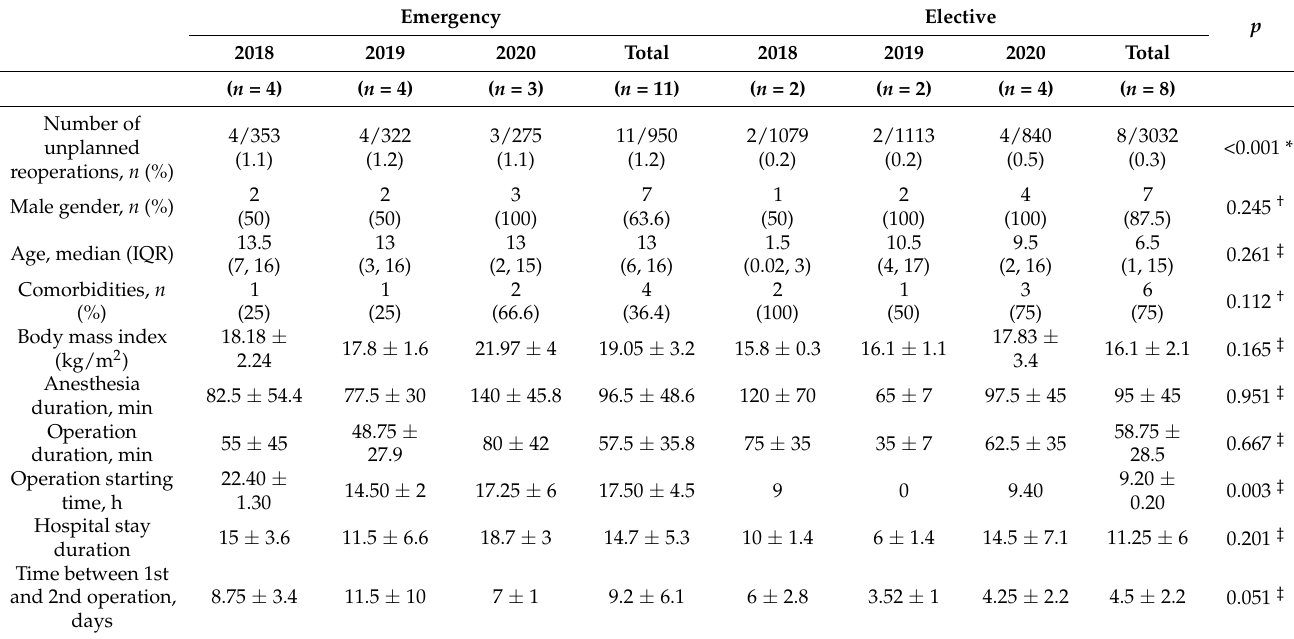
Table 3. Demographic and clinical characteristics of patients who had an unplanned reoperation in the 30-day postoperative period.